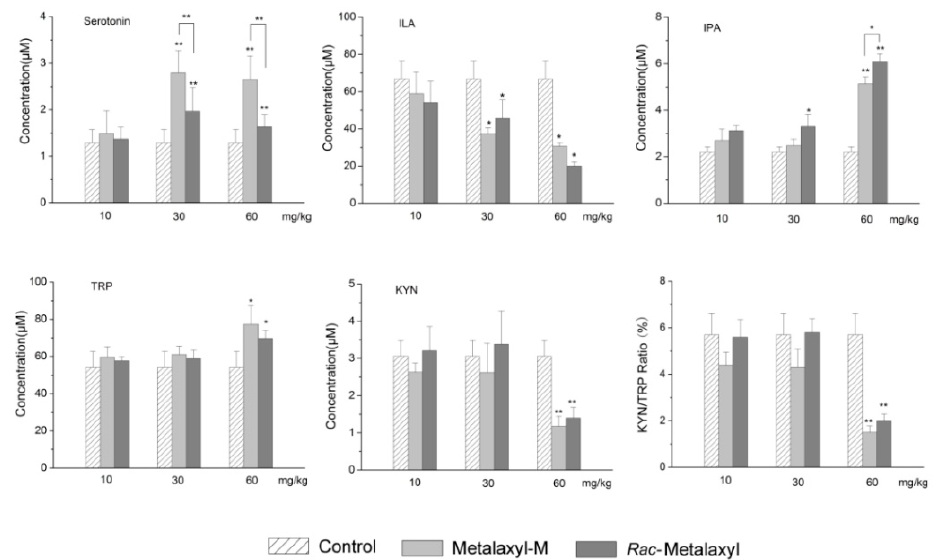
Figure 8. Tryptophan pathway metabolites changes induced by rac -metalaxyl and metalaxyl-M. Asterisks indicate significant di ff erences (* p < 0.05 and ** p < 0.01) between treatment and control